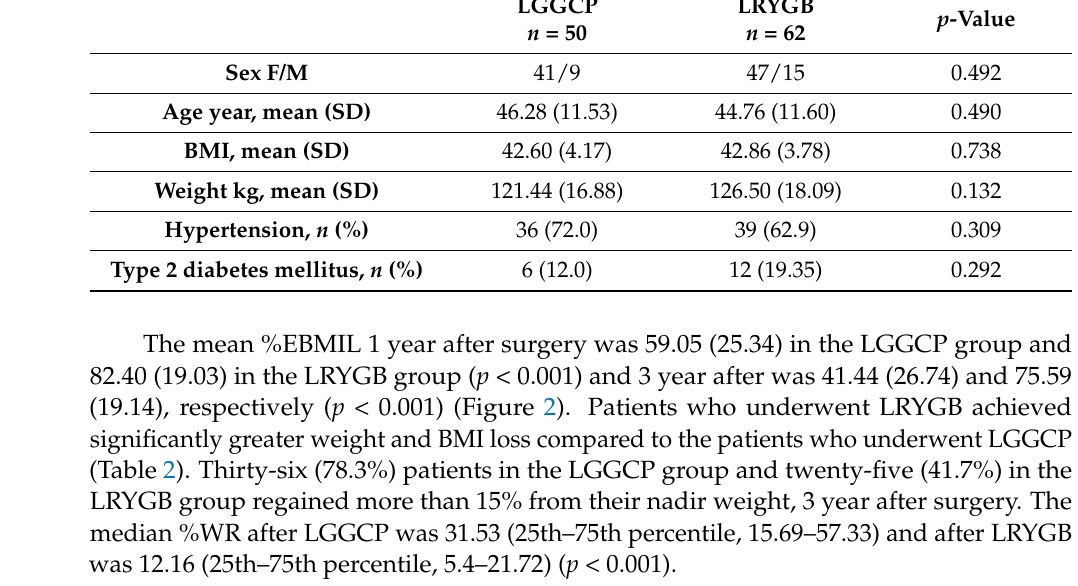
Table 1. Baseline characteristics of the patients included in the study.